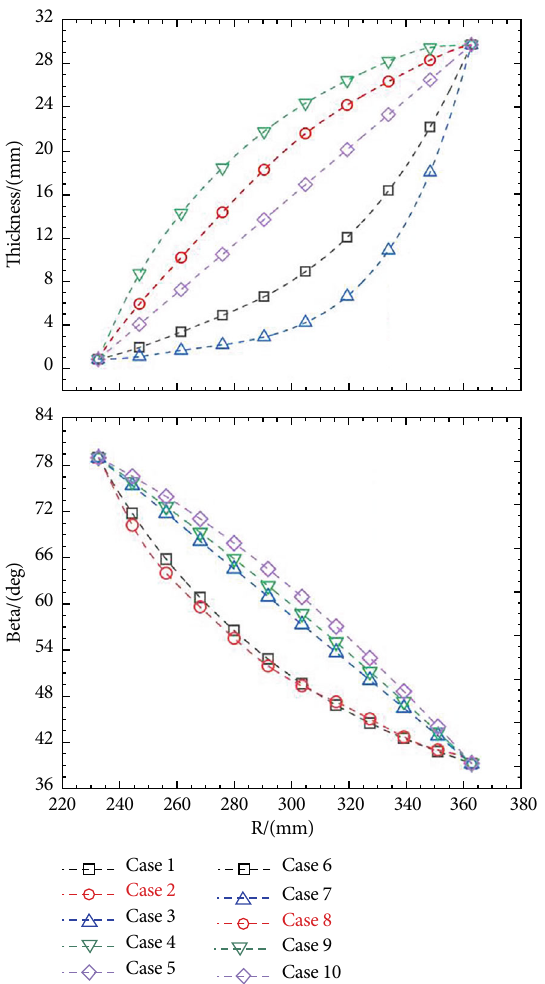
Figure 10: V distributions for di ff erent t